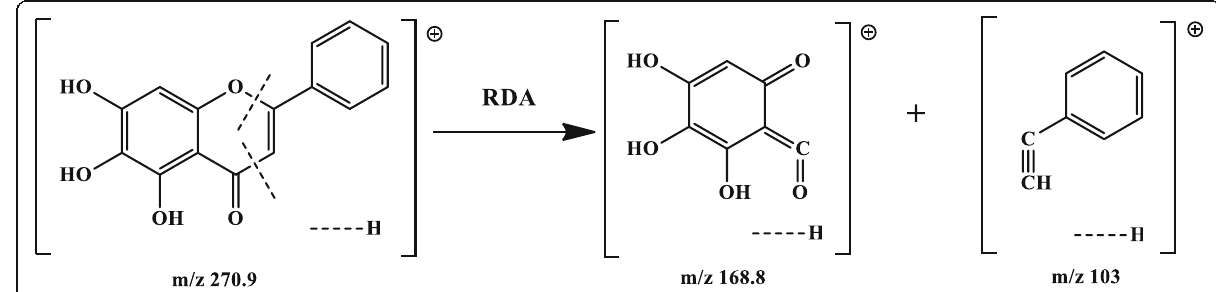
Fig. 4 Analysis of the cracking pathway of baicalein (peak 20 in Fig. 2c) using ESI-MS scanning in positive ion mode